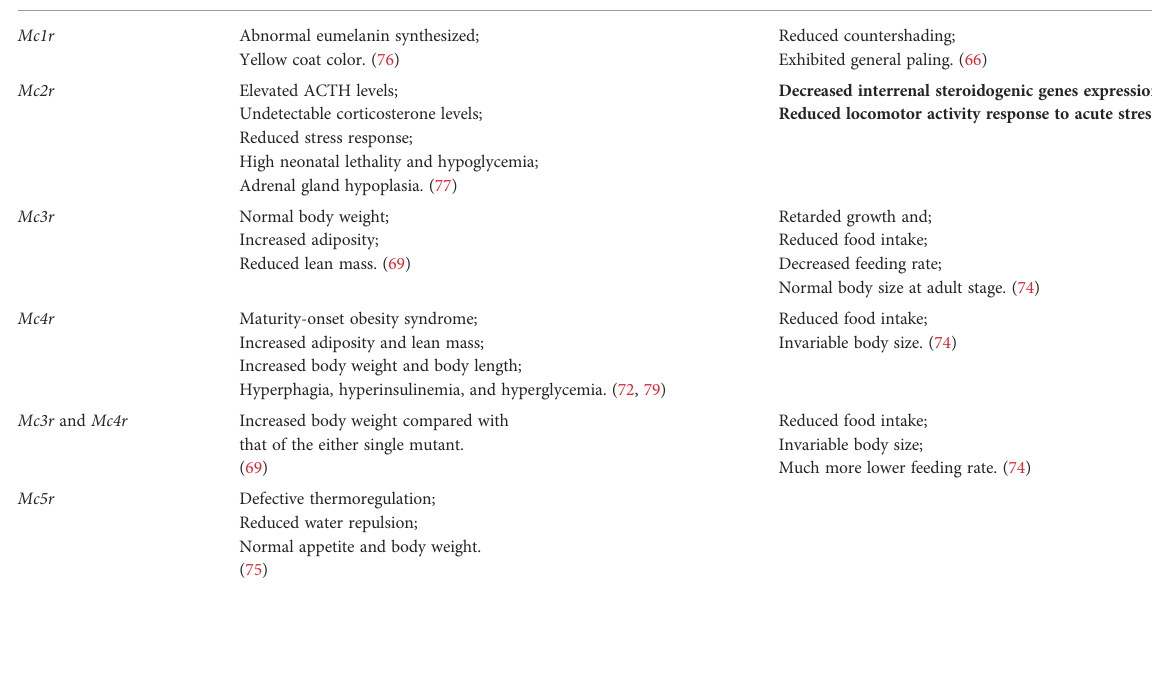
TABLE 3 Comparison the major phenotypes of melanocortin receptors gene mutation in mouse and zebra fi sh models. Gene Major defects observed in mouse model Major defects observed in zebra fi sh model